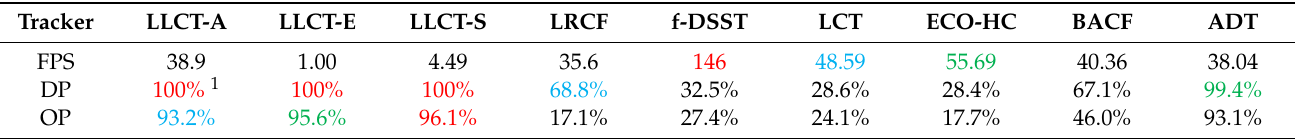
Figure 11. Field experiment in the underground garage. The proposed method performed well in a low-illumination environment. Table 3. The average operating speed and performance.